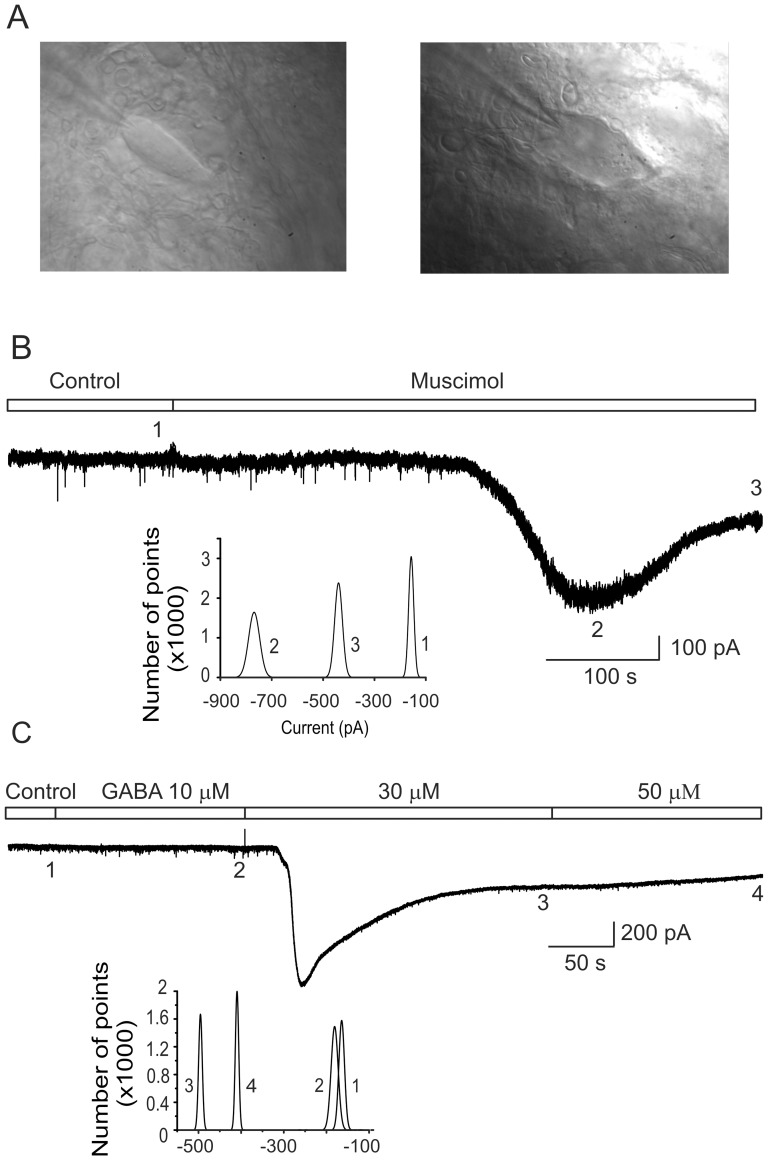
Recording of a GABAergic tonic inhibitory current in motoneurons.A) Images of two patched motoneurons from the ventral horn of the turtle spinal cord viewed with an upright microscope using oblique illumination. B) Representative trace of the holding current recorded in one motoneuron held at −70 mV in control Ringer and in the presence of the GABAA receptor agonist muscimol (5 µM). C) Trace recording of the holding current recorded from one motoneuron held at −70 mV before (control Ringer) and after application of increasing GABA concentrations as indicated. The numbers under the trace denote the time at which 5000 current points were taken to build the histograms shown in the inset.